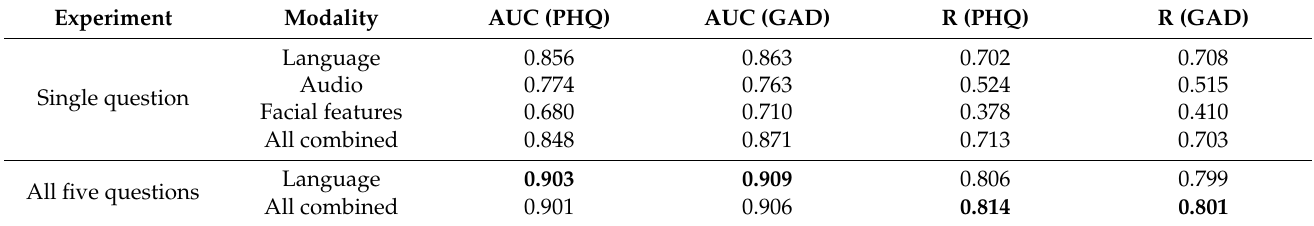
Table 1. Experimental results for each modality for a single question (top rows) as well as all questions (bottom rows). Models are scored on the area under the receiver operating characteristics curve (AUC) when the model was scored as a classifier (positive cases when PHQ-9/GAD-7 scored ≥ 10), and Pearson correlation (R) when the model was scored as a regressor. Bold values show the best score in each